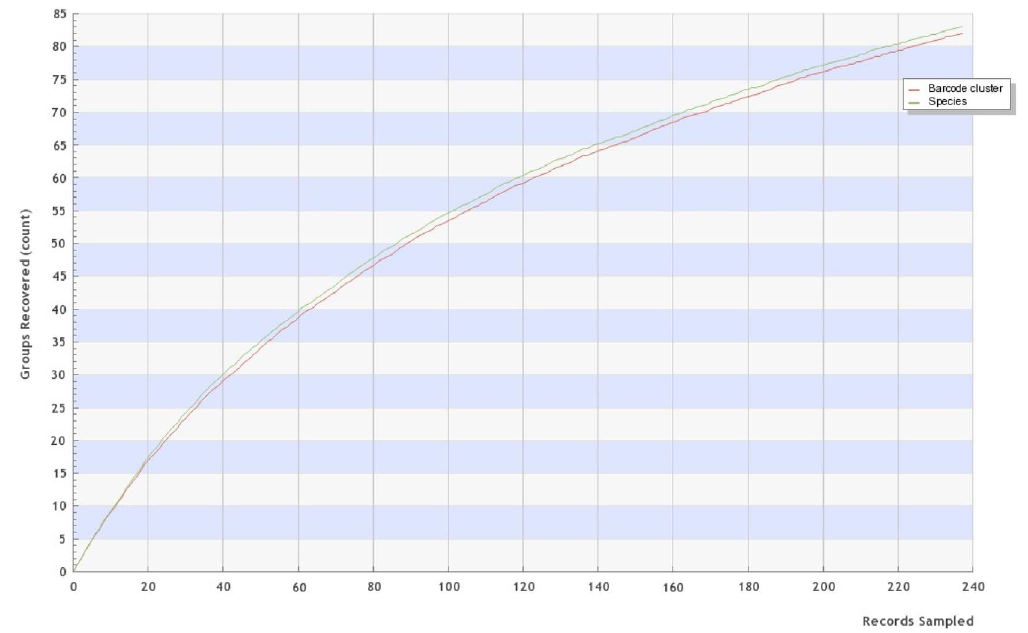
Figure 2. Accumulation curve for the 83 species and 82 BINs with DNA barcodes from Bavarian species. Accumulation curve (from BOLD database; randomized; 100 iterations) for the 237 barcoded individuals ( . 500 bp).